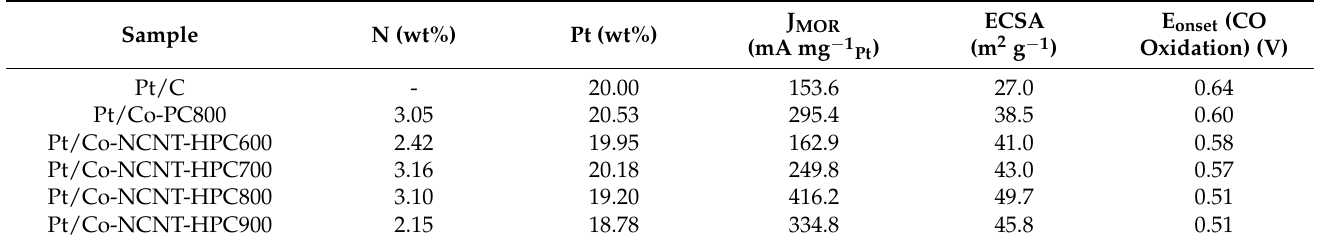
Table 2. Electrochemical data of Pt-based composite